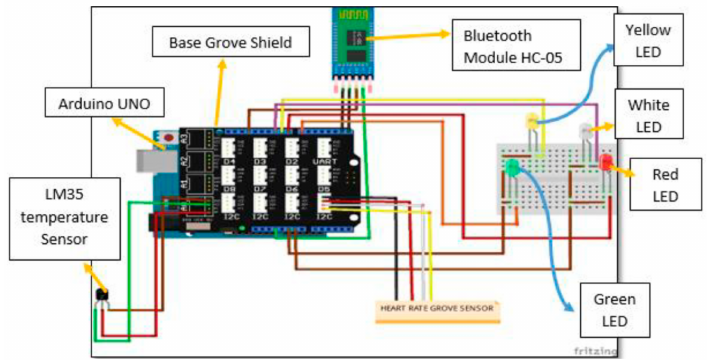
Figure 8. Circuit diagram of the temperature and heart rate monitoring system. From [144], originally published under a CC-BY